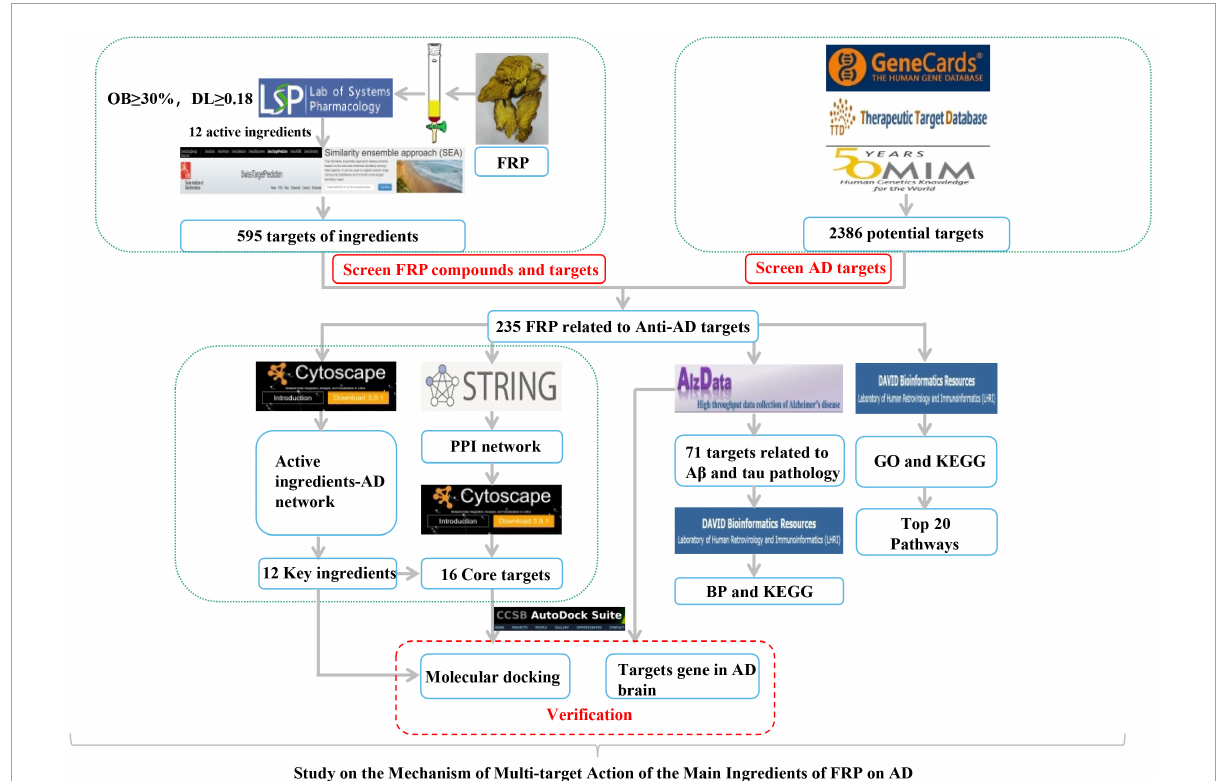
FIGURE1 Flowchart of the